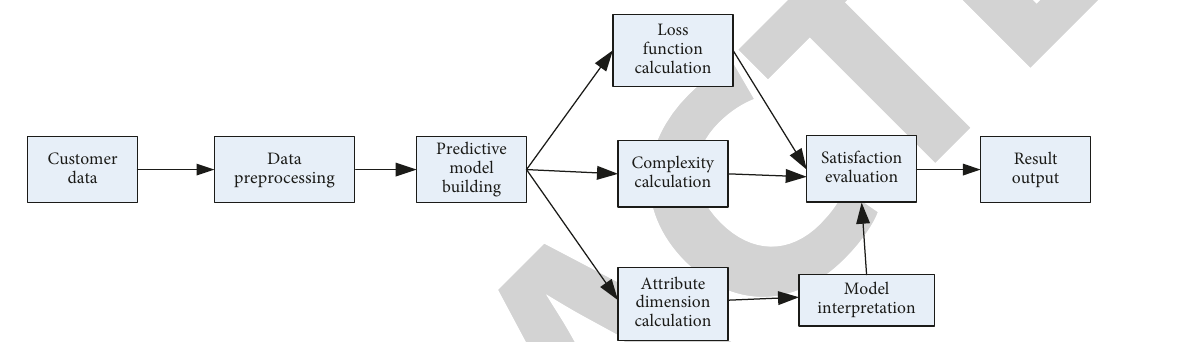
Figure 7: Two types of wrong customer churn prediction